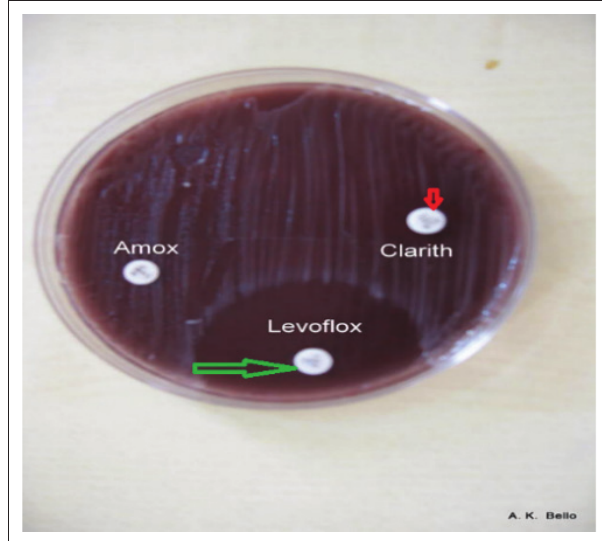
FIGURE 2: Helicobacter pylori growth inhibited by levofloxacin (green) and clarithromycin (red) above.